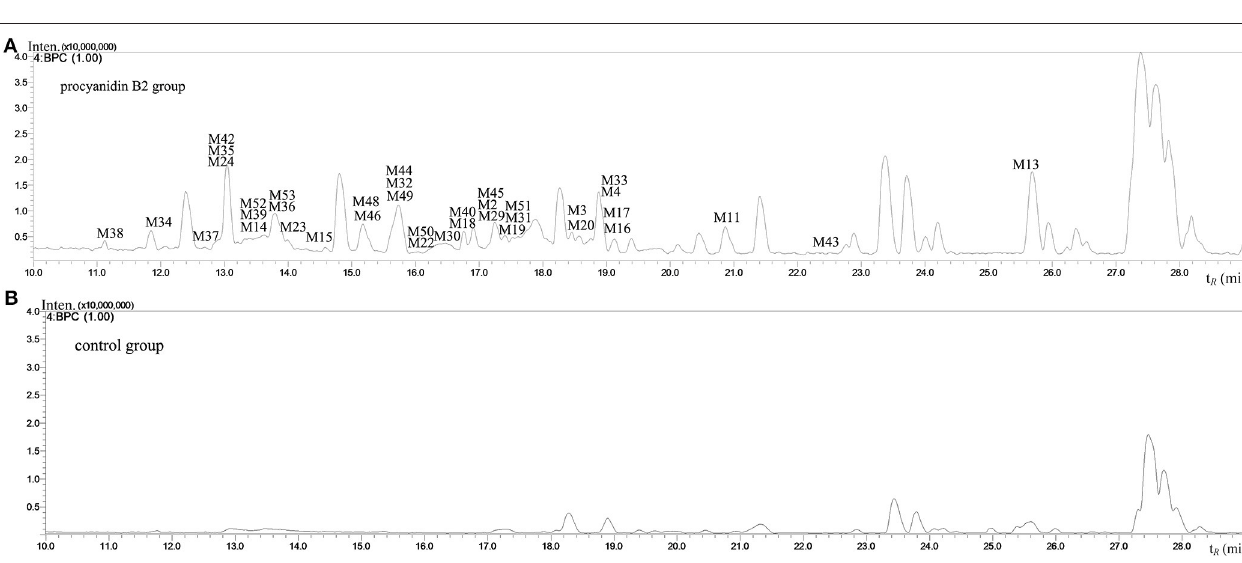
FIGURE 4 | The negative ion base peak chromatograms of mice plasma. (A) The BPC of plasma of Procyanidin B2 group; (B) The BPC of plasma of control group.